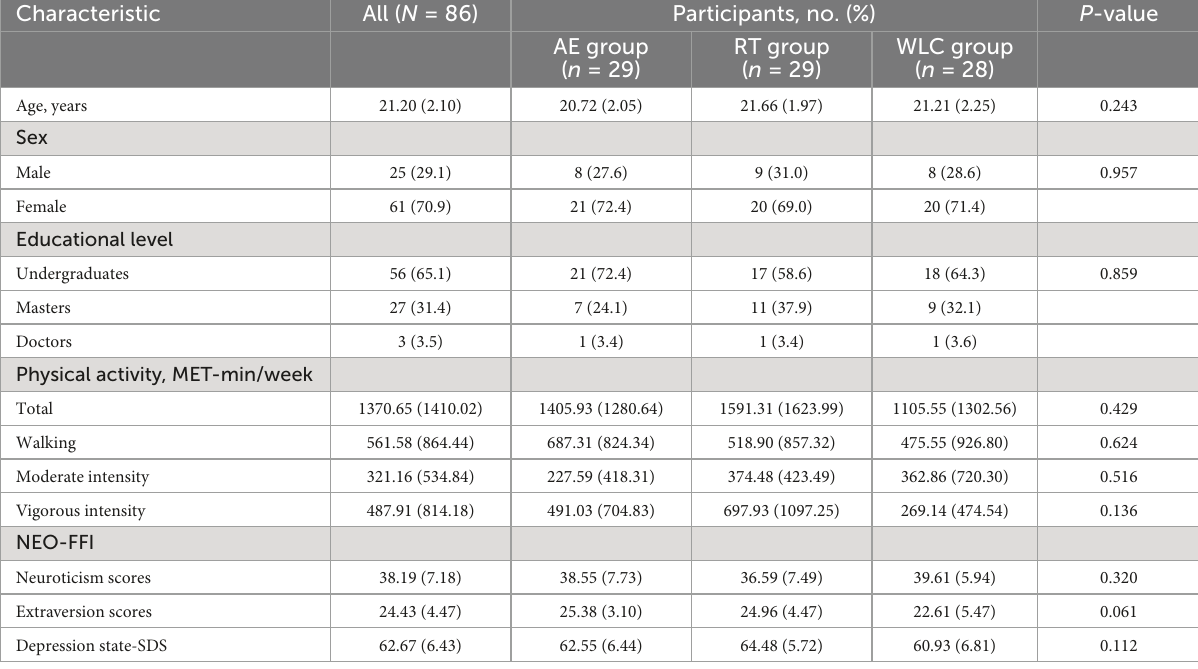
TABLE 3 Baseline characteristics of the participants ( N = 86).